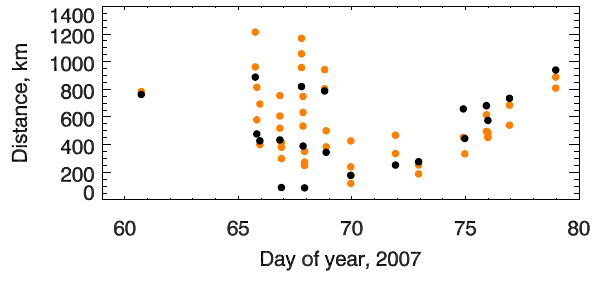
Fig. 6. Distance between comparable ACE-FTS and 125HR mea- surements, as measured from the ACE 30-km tangent point to PEARL (black) and from the measurement location at 18km for both instruments